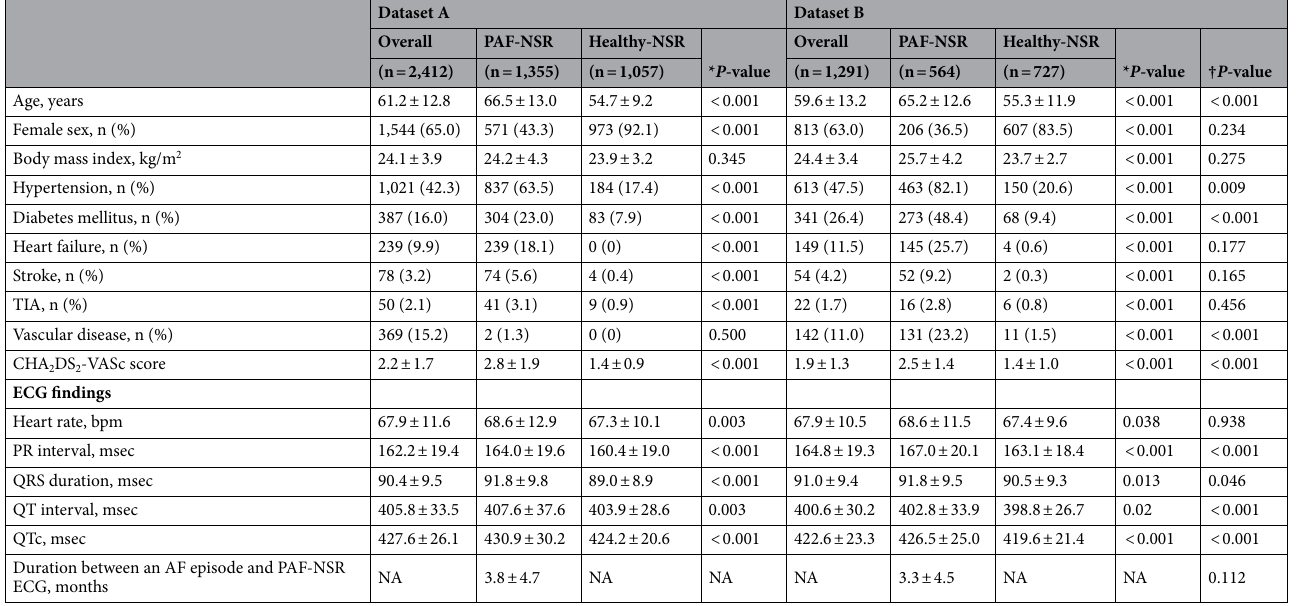
Table 1. Patient characteristics and electrocardiographic findings at enrollment. Values are expressed as n (%) or as means ± standard deviations. NA means not applicable. * P value of Student’s t-test or chi-square test between PAF-normal and healthy-NSR participants. † P value of Student’s t-test or chi-square test between datasets A and B. bpm: beats per minute; CHA2DS2-VASc: a score taking into account congestive heart failure, hypertension, age ≥ 75 years, diabetes mellitus, previous stroke/transient ischemic attack, vascular